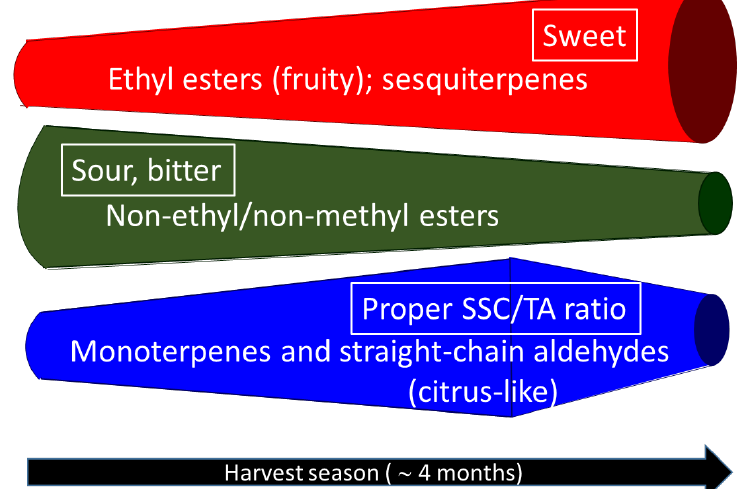
Figure 4. A schematic diagram to demonstrate the change patterns of different non-volatile (boxed) and volatile (non-boxed) flavor chemical compounds along with harvest time (from February/March to May/June) in “Valencia” orange juice. The width of the band indicates the relative abundance of each chemical class/attribute except for SSC/TA ratio which represents the optimal quality.